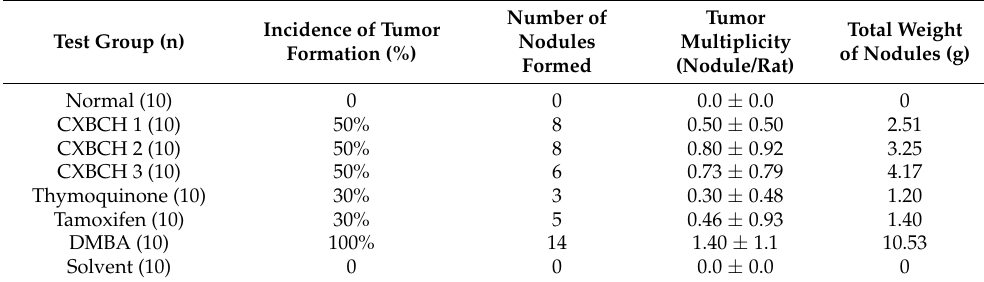
Table 4. The examination results of the number of nodules in DMBA-induced female SD rats receiving CXBCH treatment two weeks before and five weeks during